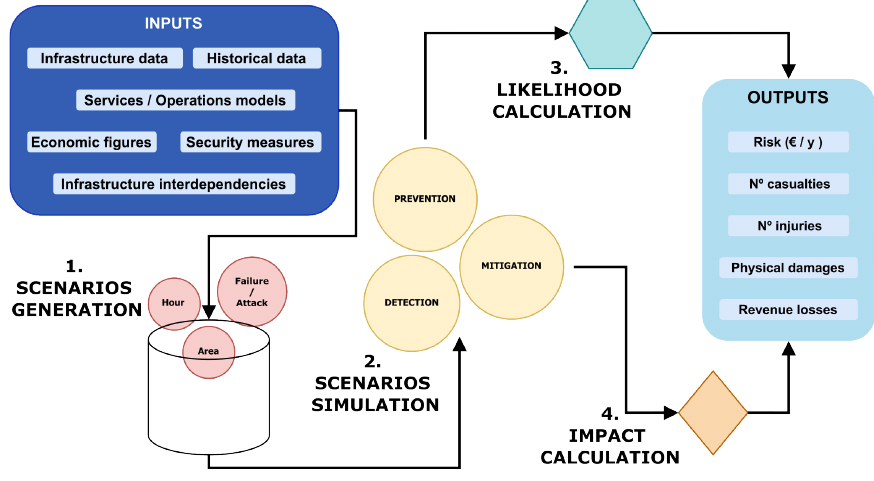
Figure 1. Risk Management Algorithm Structure.